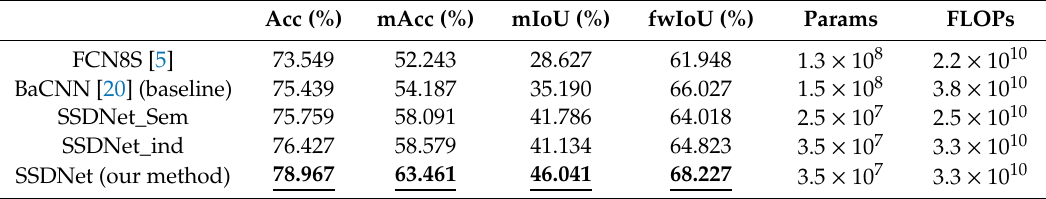
Table 2. Semantic segmentation ablation experiment on Virtual KITTI